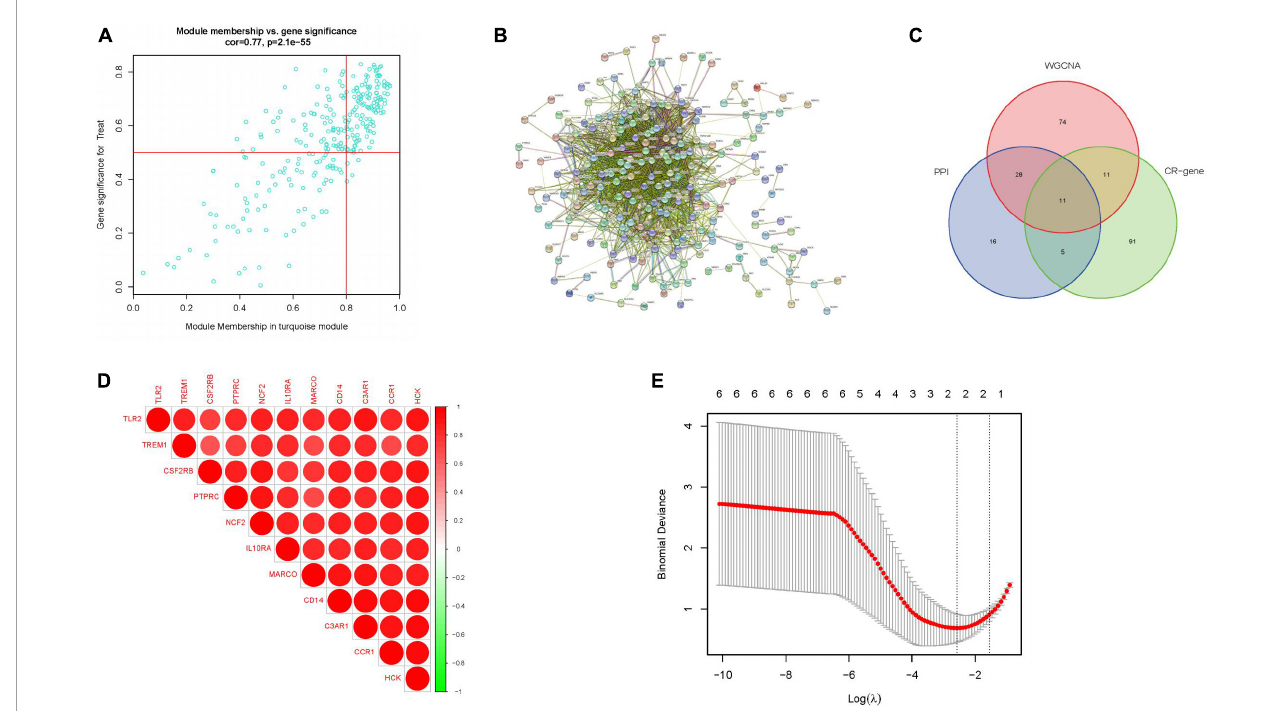
FIGURE5 Key gene screening. (A) Meturquoise module gene scatter plot. (B) PPI of meturquoise module genes. (C) Veen plot of intersecting genes. (D) Correlation heat map of intersecting genes. (E) Lasso analysis. (CR-gene represents circadian regulated differential